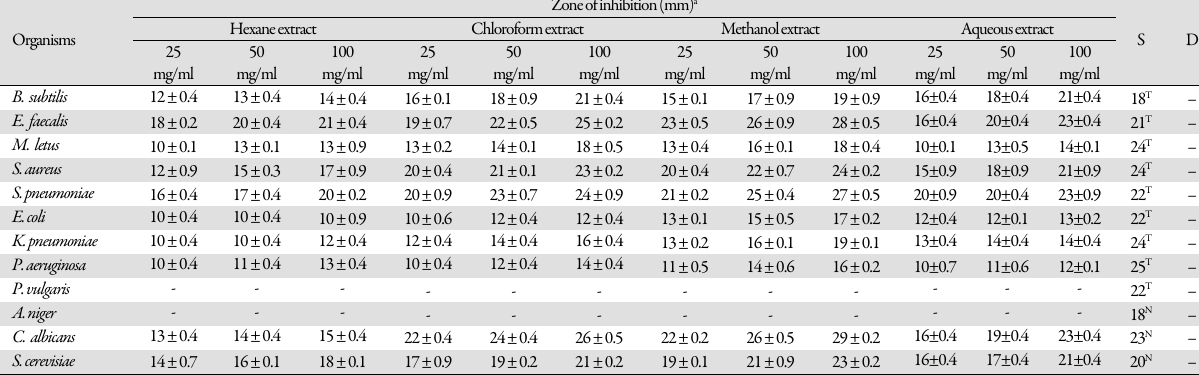
Table 1. The antimicrobial activity of Bridelia retusa fruit extracts against various pathogens Organisms